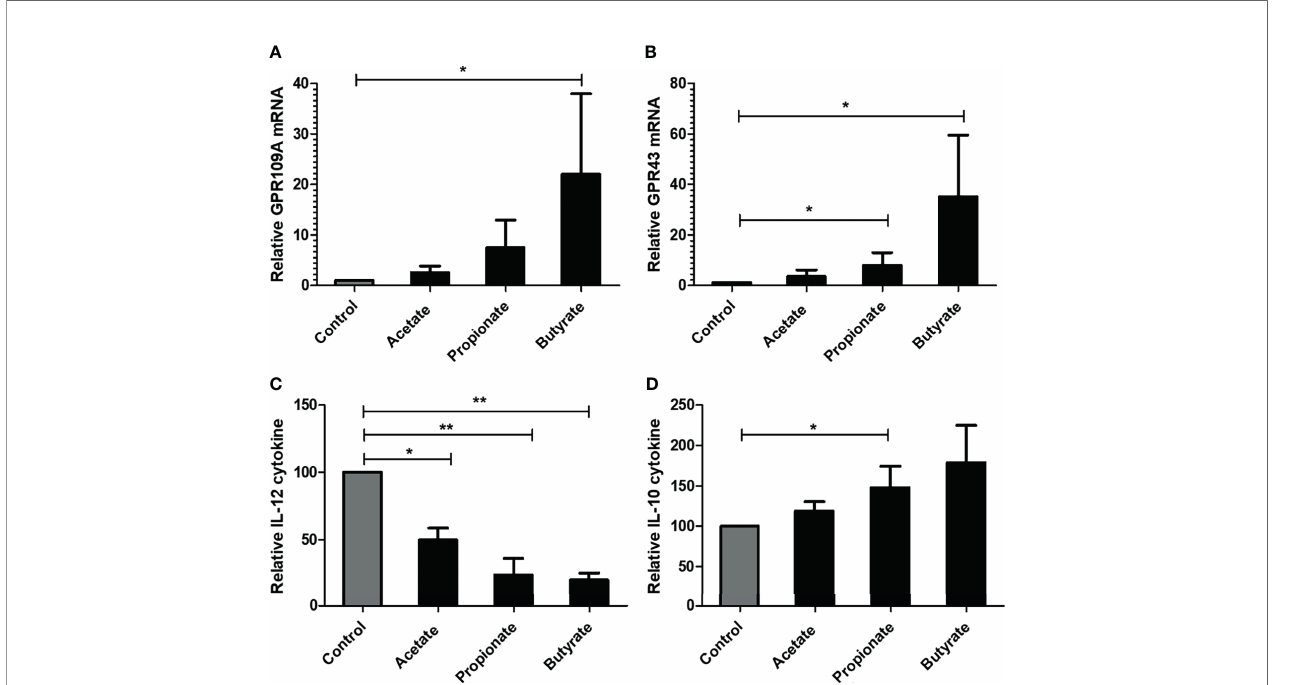
FIGURE 6 | Effect of SCFA on in-vitro generated human monocyte derived DCs. DCs were cultured for 7 days and were stimulated with 100 ng/ml LPS for 48 hours. (A, B) GPR109A and GPR43 expression in mature DCs in presence of SCFA. (C) IL-12 cytokine release by DCs in presence of SCFA. (D) IL-10 cytokine release by DCs in presence of SCFA. n= 3 healthy donors. Bar represents mean +/- s.e.m. *p < 0.05, **p < 0.01, Mann-Whitney U test for A, B and D (non-normal distribution), one way ANOVA with Bonferroni correction for C (normal